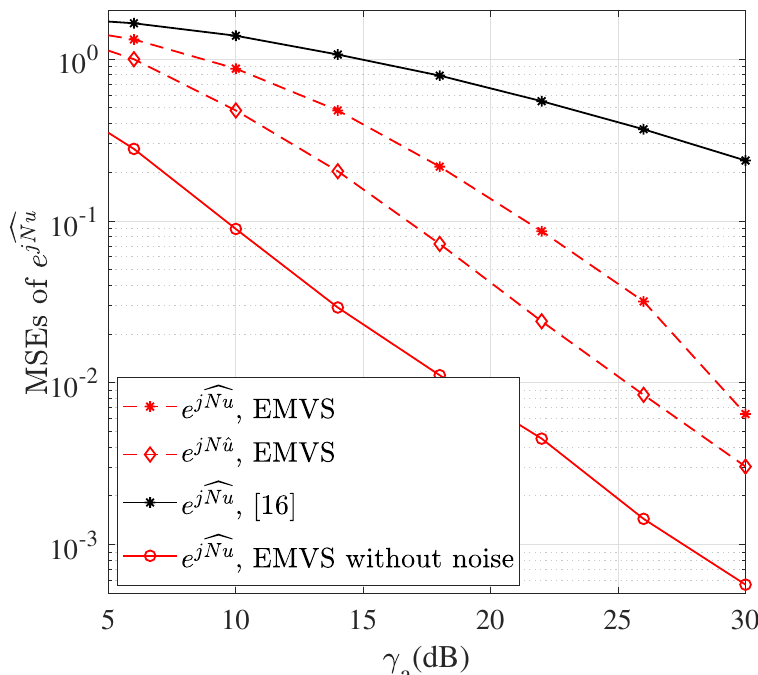
Figure 3. The MSEs of e j (cid:99) Nu versus γ a